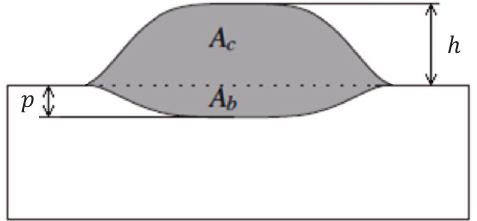
Fig. 1. Cross­section of the cladding